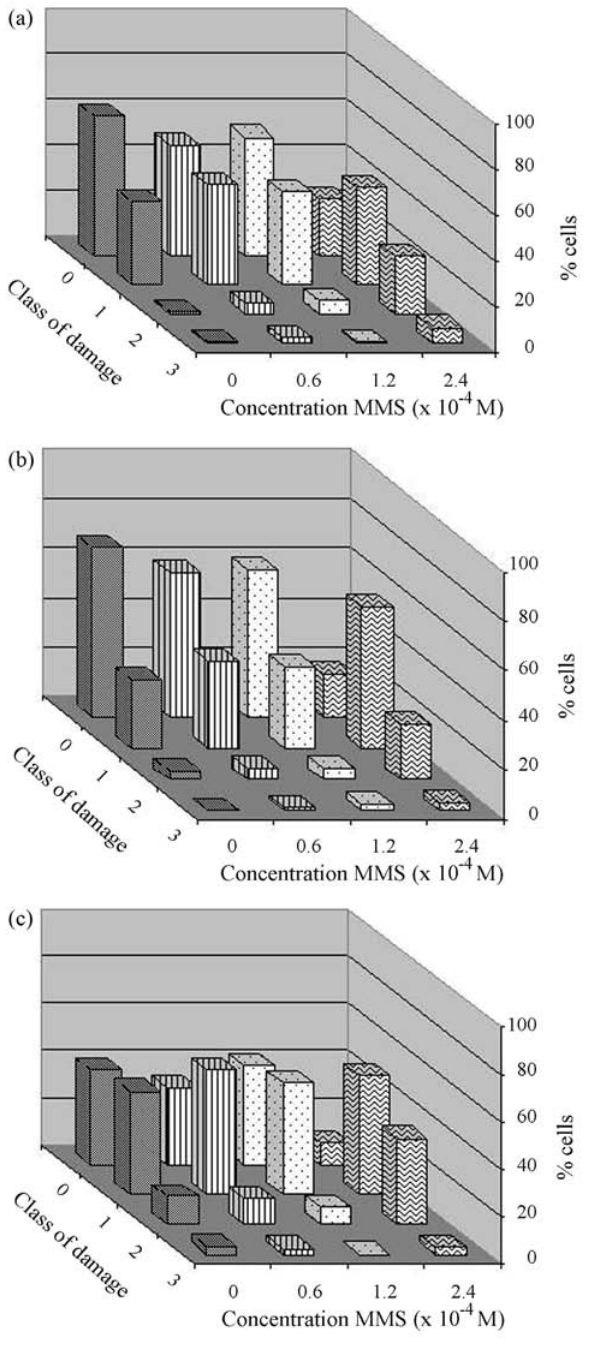
Figure 3 - Frequency of DNA damage in hemolymph (a), digestive gland (b)andgill(c)cellsaftertreatmentwithmethylmethanesulfonate(MMS). Mean values for 4 replicates.